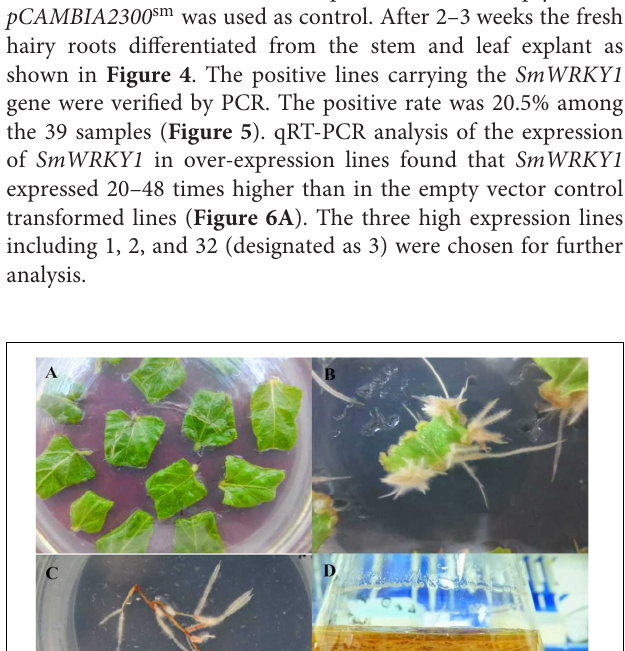
pCAMBIA2300 sm vector (Supplementary Figure S4). Then